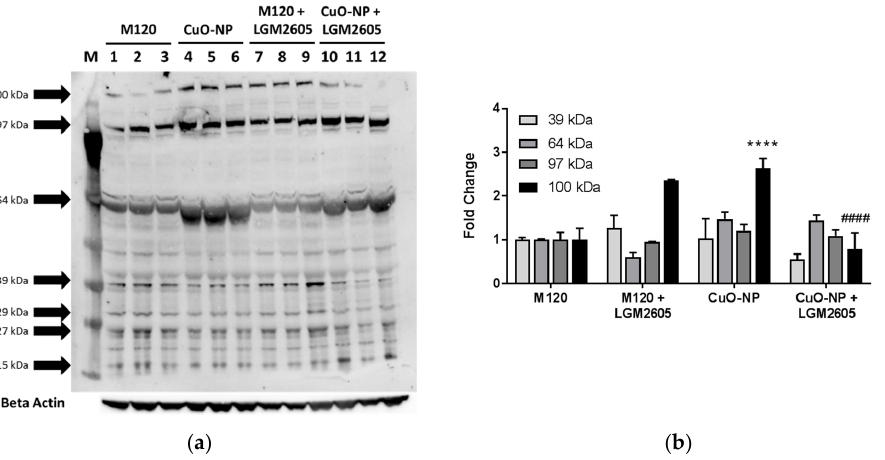
Figure 6. LGM2605 treatment reduces CuO-NP-induced increase in protein chlorination in murine lung. ( a ) Western blot analysis of chlorinated lung proteins (M, marker; lanes 1–3, M120; lanes 4–6, CuO-NP; lanes 7–9, M120 + LGM2605; lanes 10–12, CuO-NP + LGM2605); ( b ) densitometric analysis of chlorinated proteins from murine lung homogenates exposed to M120 or CuO-NP and treated with or without LGM2605. All data are presented as the mean ± the standard error of the mean. Asterisks indicate a statistically significant difference from M120 (**** p < 0.0001) and # indicates a statistically significant difference from CuO-NP (#### p < 0.0001).